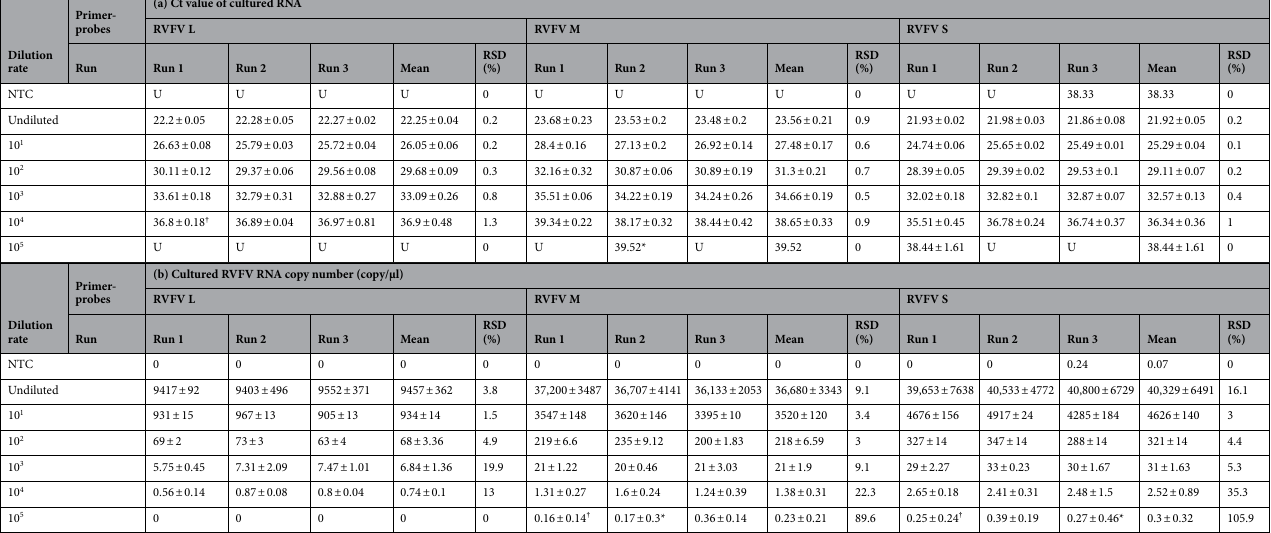
Table 1. Limit of Quantification (LoQ) of the cultured RVFV RNA by RT-qPCR with the L, M and S segment assay. (a) Each run represents the mean Ct value of three replicates within an independent run. *Only one of three replicates were positive. † Only two of three replicates were positive. The ‘U’ indicates underdetermined. (b) Each run represents the mean copy number of three replicates within an independent run.